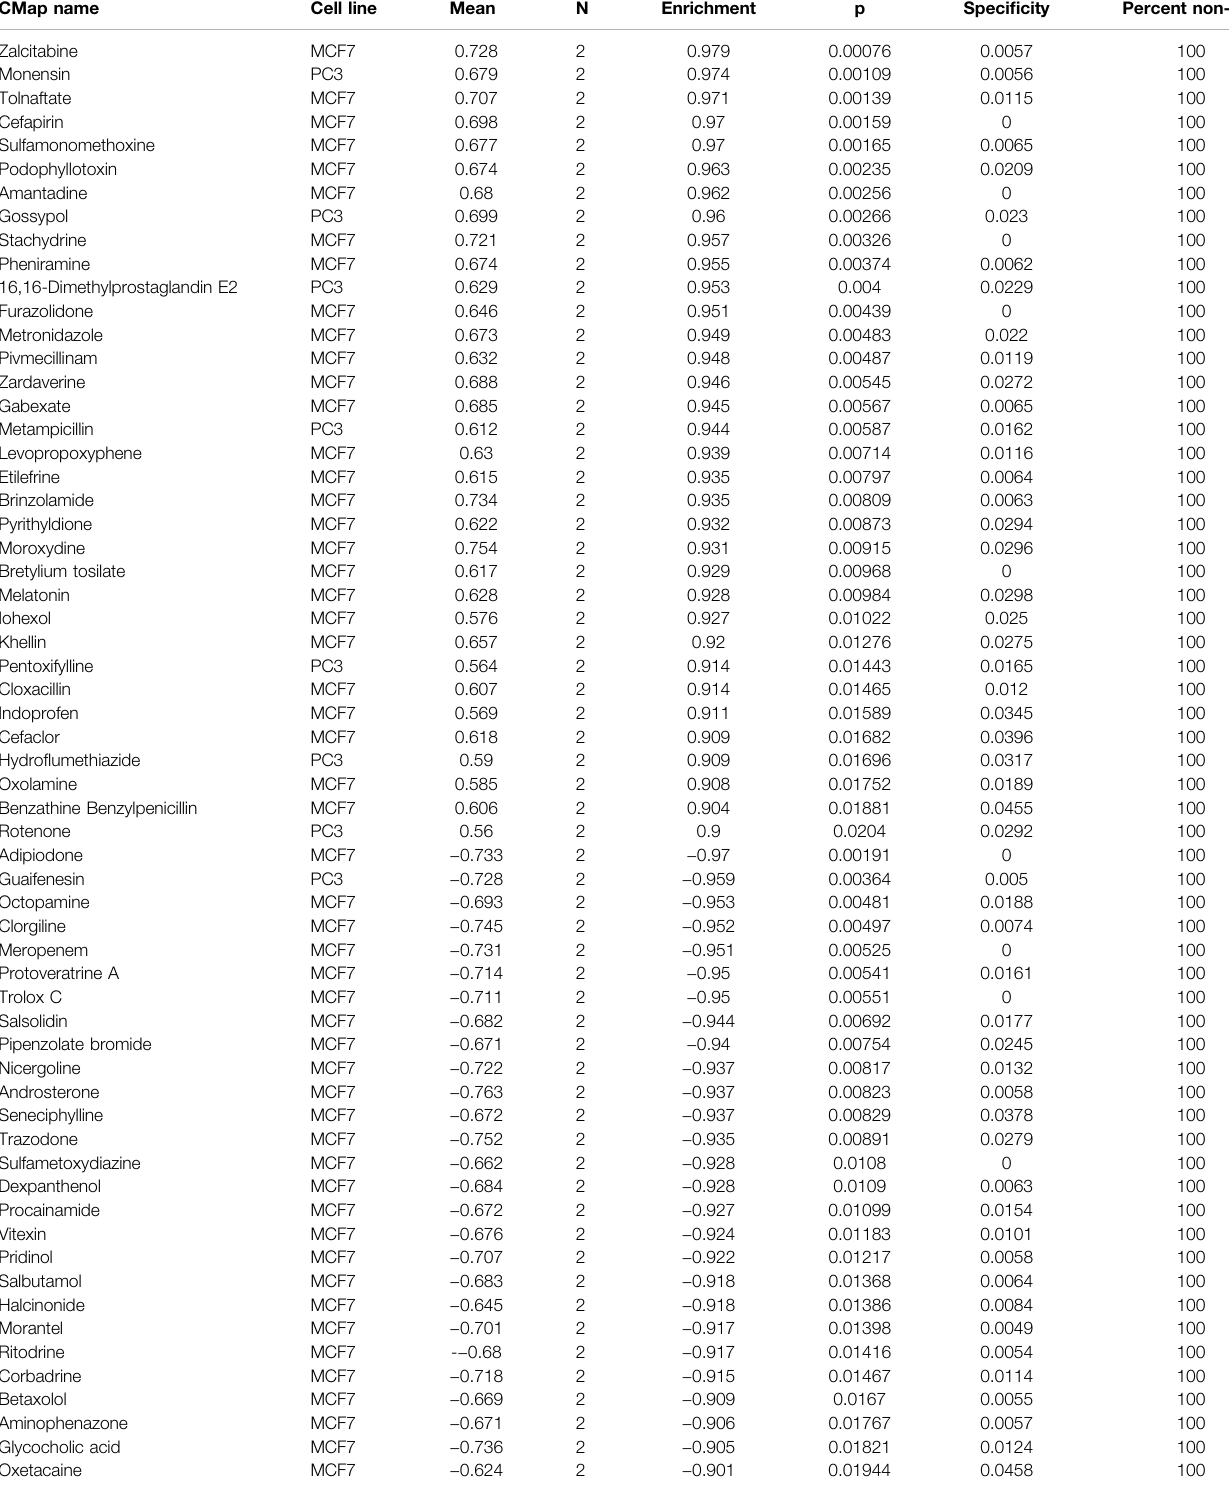
TABLE 2 | Potential small molecule drugs for osteosarcoma by connectivity map (cMap)